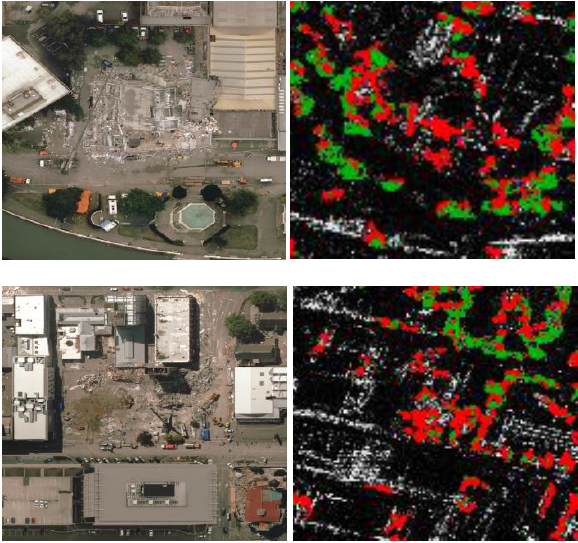
Figure 10. Two scenes of a destroyed building in the EO image (left) and their correct identification as